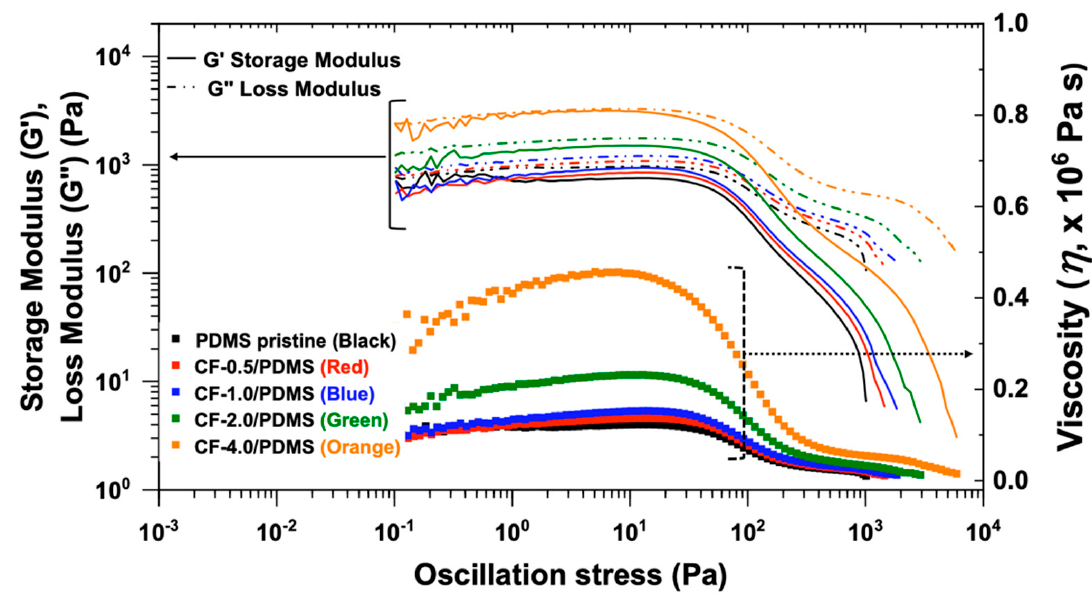
Figure 1. Rheological properties of polydimethylsiloxane (PDMS) pristine and CF/PDMS composites as a function of carbon nanofibers (CF) contents (0.5, 1.0, 2.0, and 4.0 wt.%).